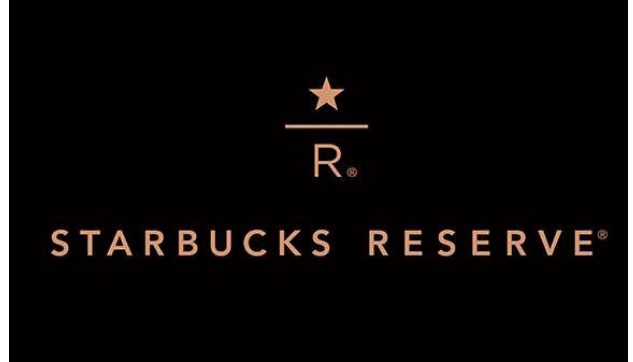
Figure 25. Starbucks Reserve logo [75].